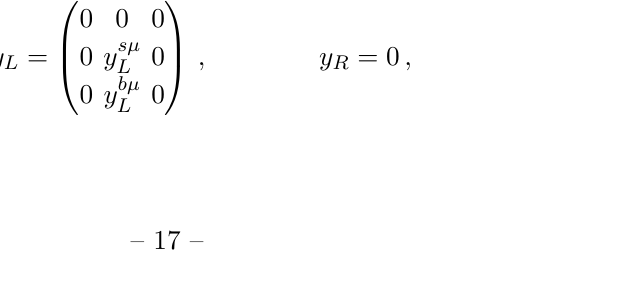
to 1 (cid:27) for both K ( (cid:3) )